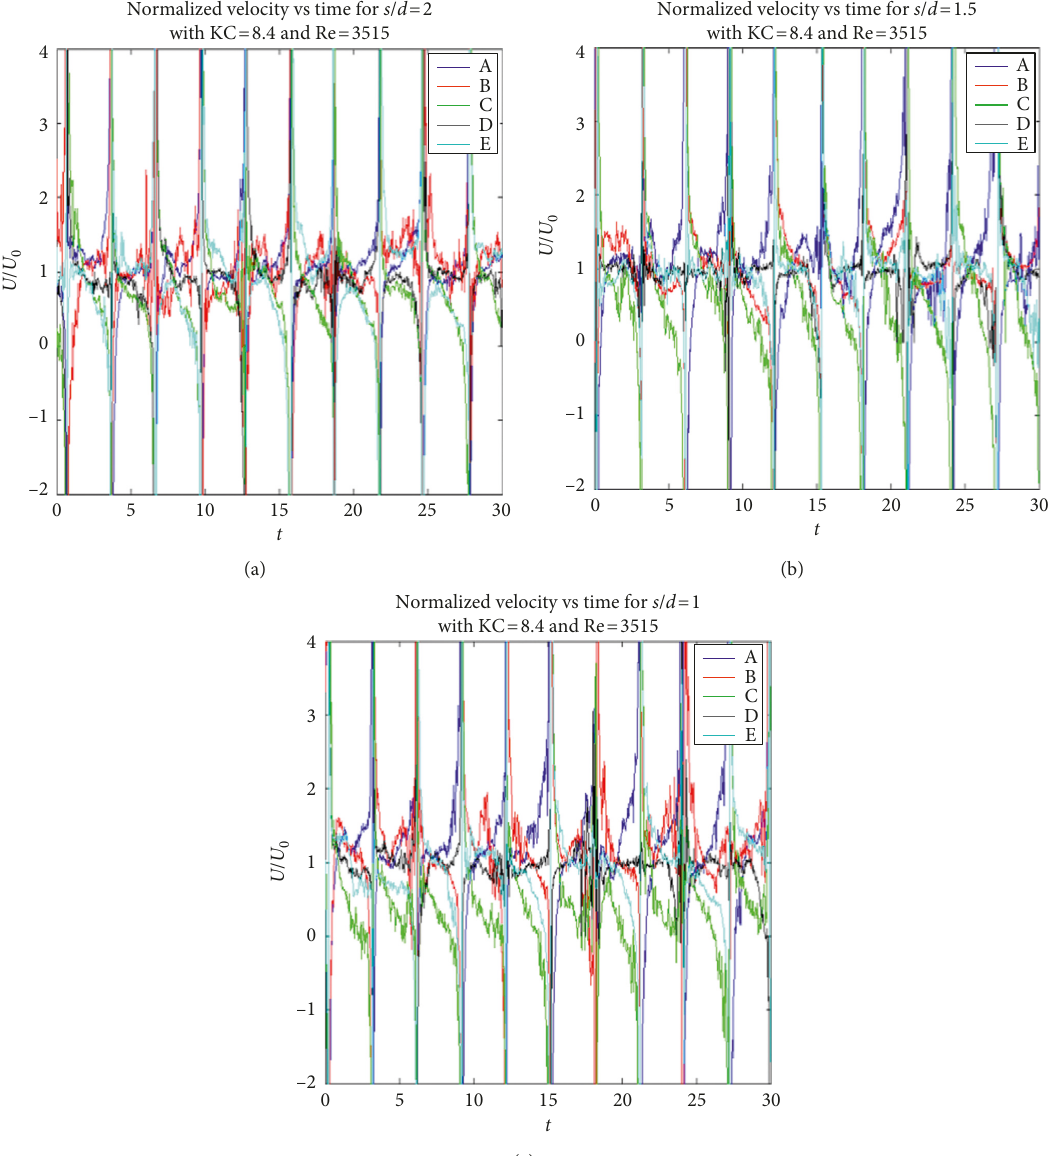
Figure 12: Normalized velocities with time for observation points, (a) s/d